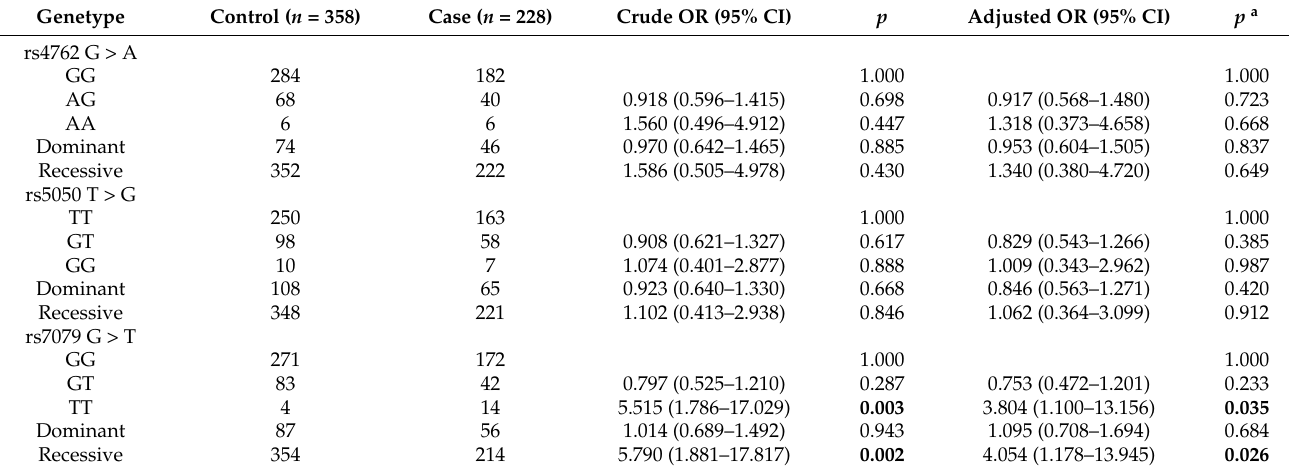
Table 2. Genotype and allelic distribution between PE and healthy